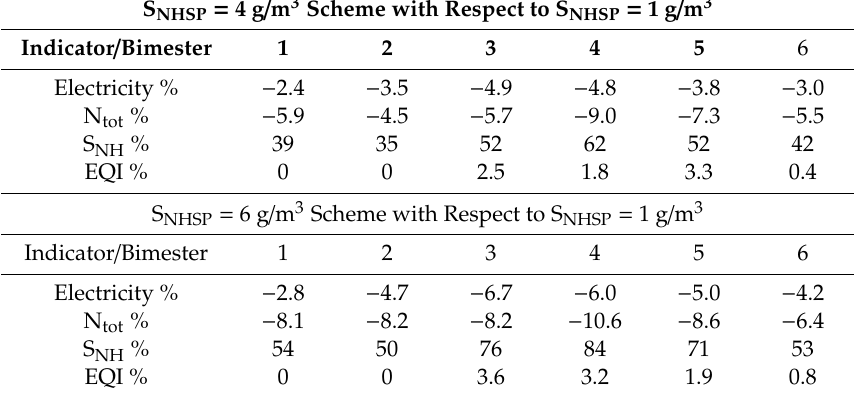
Table 8. Variation of bimonthly means of environmental indicators a ff ected by ammonium set-point (S NHSP ) changes with respect to the Cascade S NHSP control scheme with S NHSP = 1 g / m 3 .